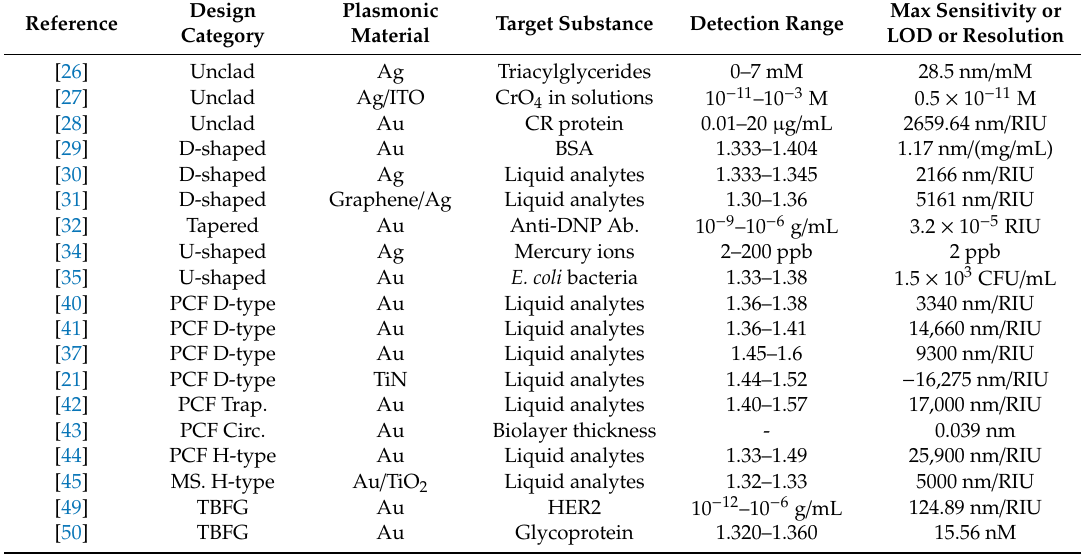
Table 1. Comparison between the design, materials, and performance of di ff erent fiber-optic plasmonic biosensors reported in this review article. Note that LOD is limit of detection, Trap. is an acronym for trapezoid, Circ. is an acronym for circular, MS. is an acronym for micro-structured fiber, and Ab. is an acronym for antibody. The detection range values are expressed in terms of RI of analyte unless specified